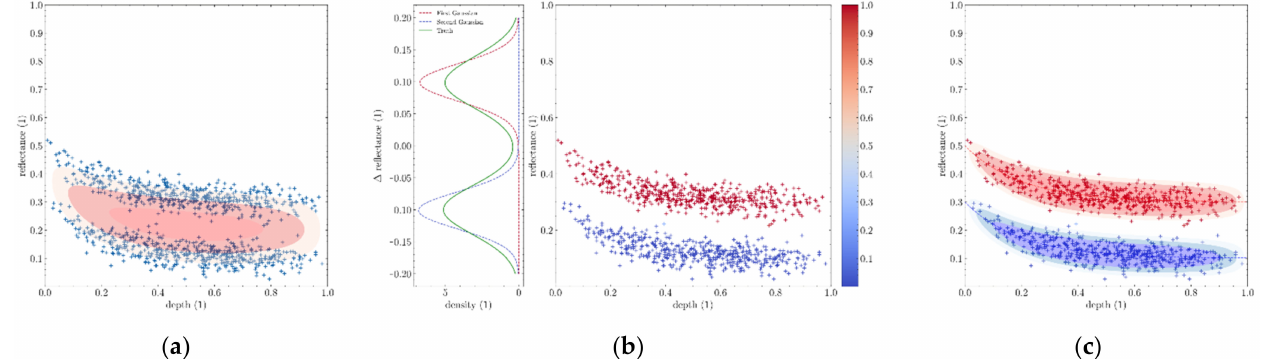
Figure 21. Splitting a distribution along the reflectance axis (relative to curve offset). ( a ) Sample points inadequately covered by a single BNP distribution. ( b ) Splitting the samples with a 2-component Gaussian mixture. ( c ) The two resulting BNP